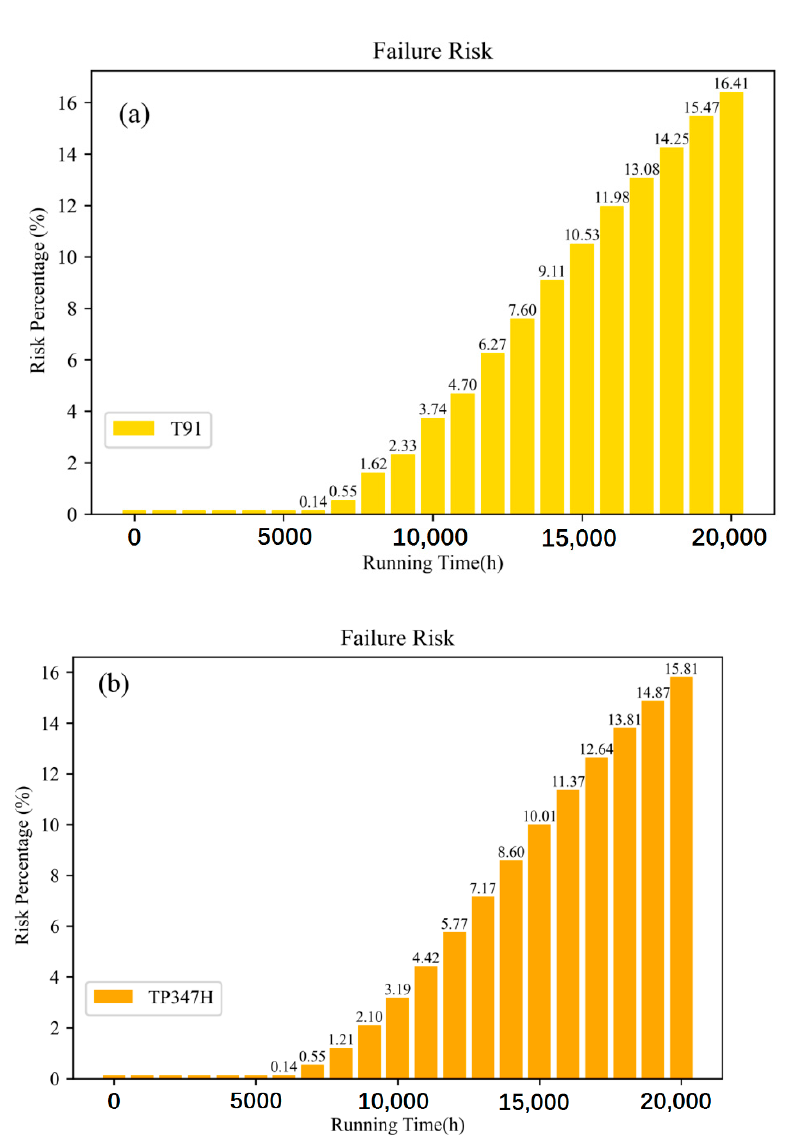
Figure 13. Material risk and remaining life trend prediction of the final-stage superheater system. ( a ) T91 material. ( b ) TP347H material.